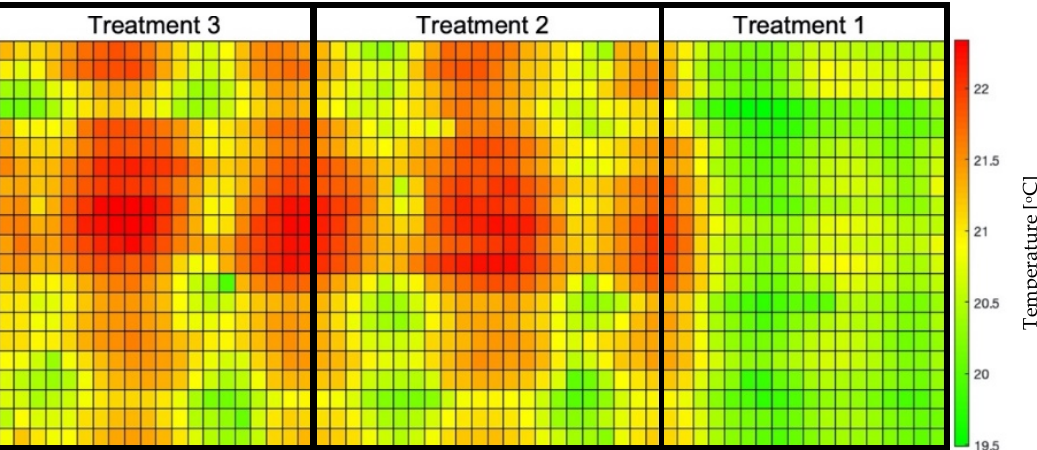
Figure 10. Thermal map of the experimental area, showing points of soil, plant, or a combination of both. The map was generated at 25DAP (Day After Planting), the final stage of culture. Treatment 1 (T 1 = 85% FC (Field Capacity)); Treatment 2 (T 2 = 75% FC); Treatment 3 (T 3 = 55%